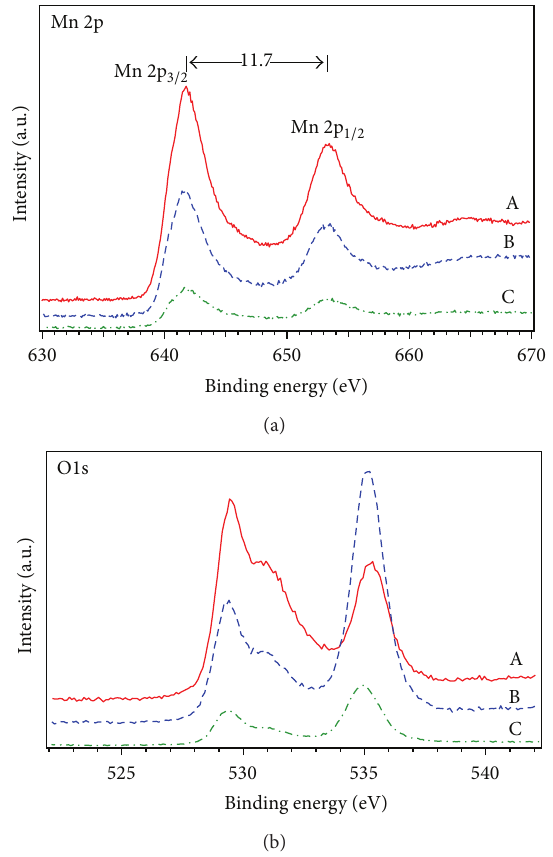
Figure 4: XPS spectra of Mn 2p and O1s (a) wpCNTs/MnO 2 (75 W, 135Pa) before cycling (b) wpCNTs/MnO 2 (75W, 135Pa) after 2000 cycles (between 0-1V), and (c) wpCNTs/MnO 2 (75 W, 135Pa) after 2000 cycles (between 0.1–0.8V).